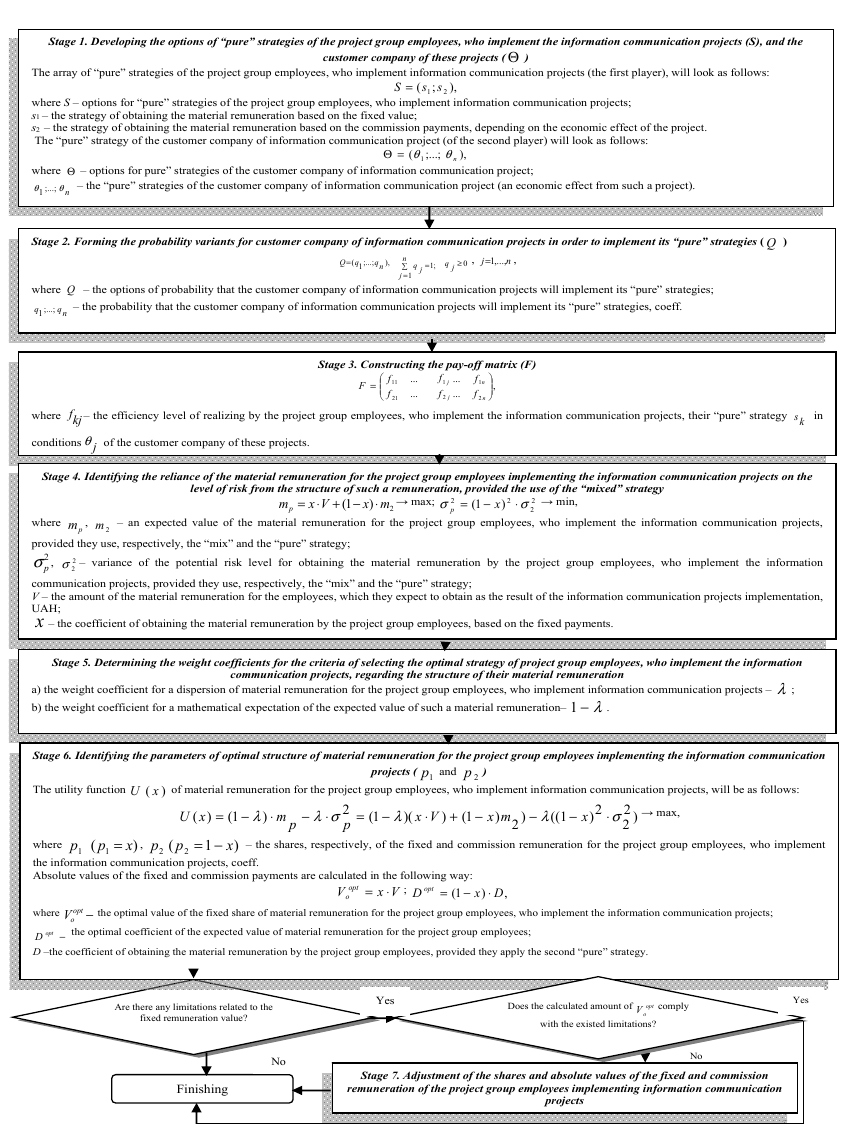
Figure 1. The generalized sequence for motivating the employees of communication departments.